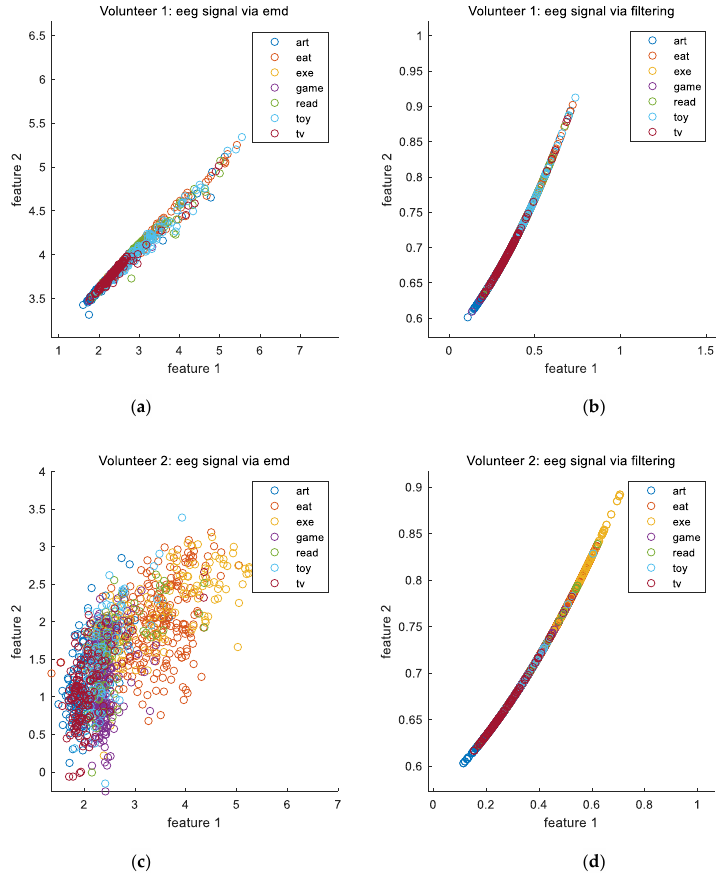
Figure 6. ( a ) Some of the features extracted from the electroencephalograms via the empirical mode decomposition approach when the first volunteer performs various activities. ( b ) Some of the features extracted from the electroencephalograms via the conventional filtering approach when the first volunteer performs various activities. ( c ) Some of the features extracted from the electroencephalograms via the empirical mode decomposition approach when the second volunteer performs various activities. ( d ) Some of the features extracted from the electroencephalograms via the conventional filtering approach when the second volunteer performs various